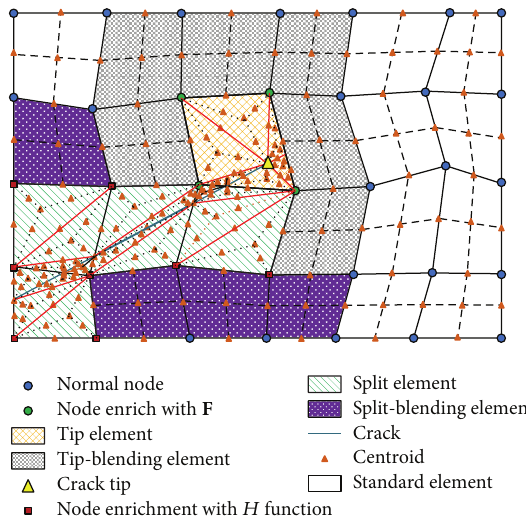
Figure 2: Classification of smoothing domains in